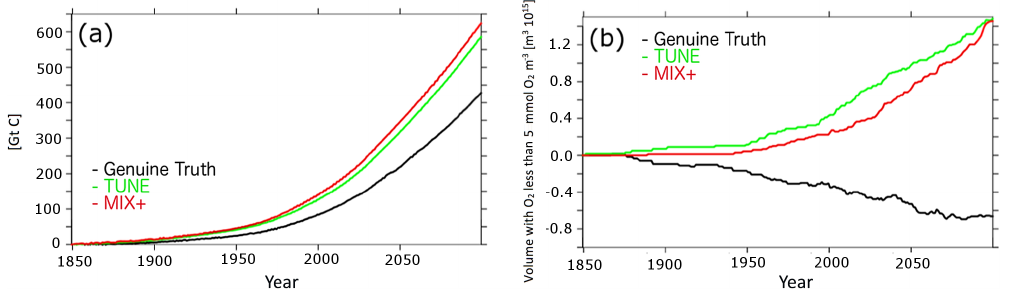
Figure 11. (a) Differences in projected anomalous total carbon content of the ocean in response to rising CO 2 concentrations (emission scenario RCP8.5; in units of gigatons of carbon). (b) Simulated temporal evolution of the volume of global suboxic waters (emission scenario